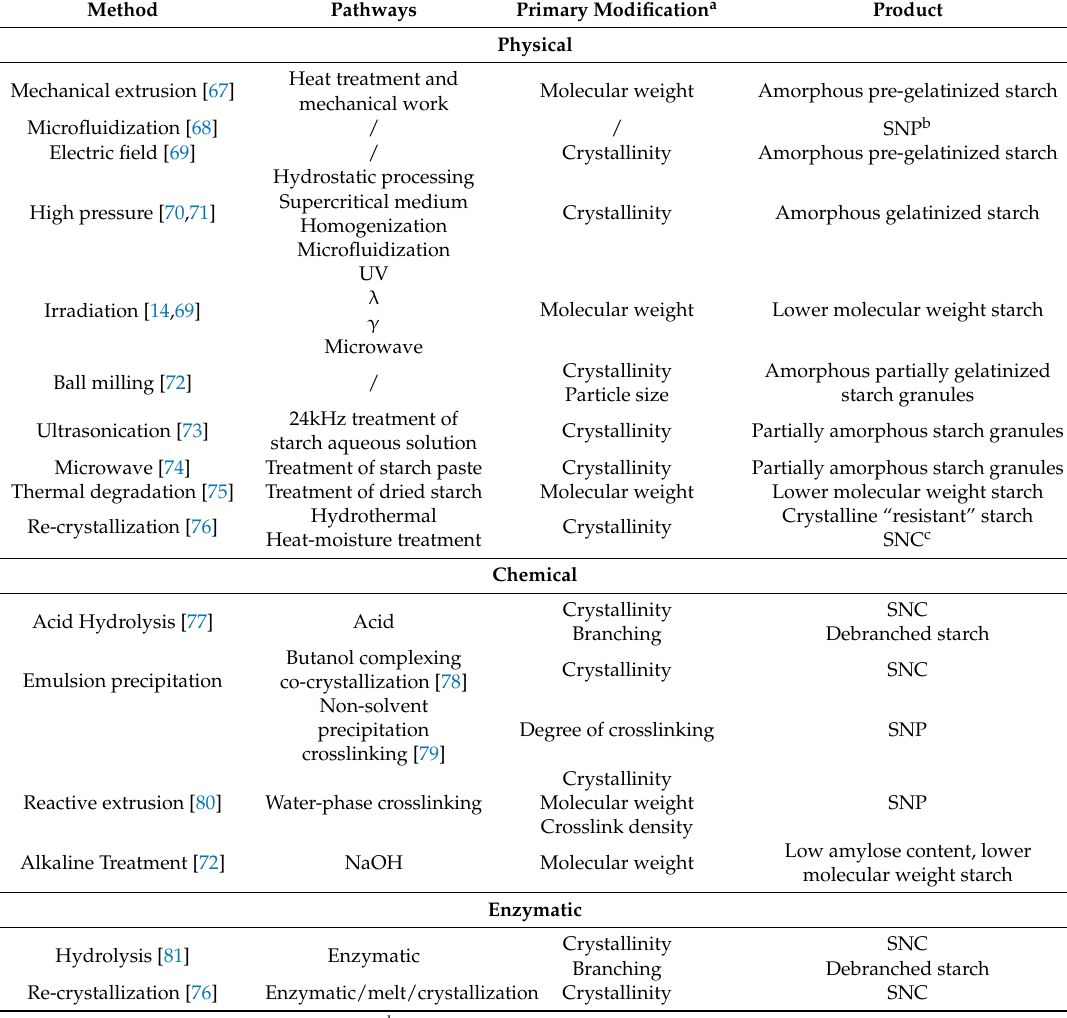
Table 1. Summary of some starch physical and chemical modification